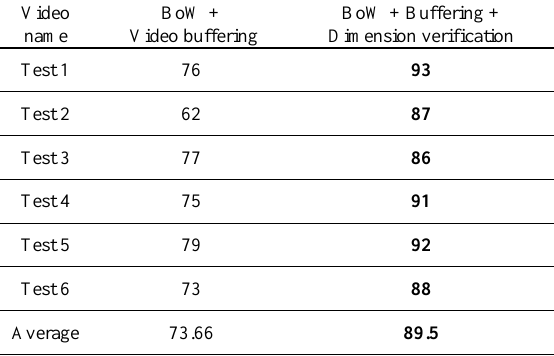
Table 6. Identification accuracy for the test